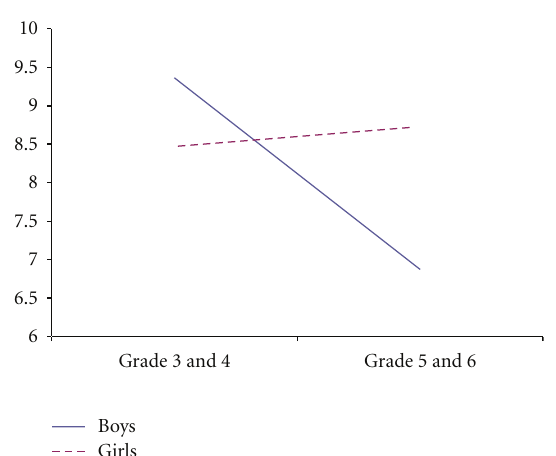
Figure 1: Sex by grade interaction for depressive symptoms.